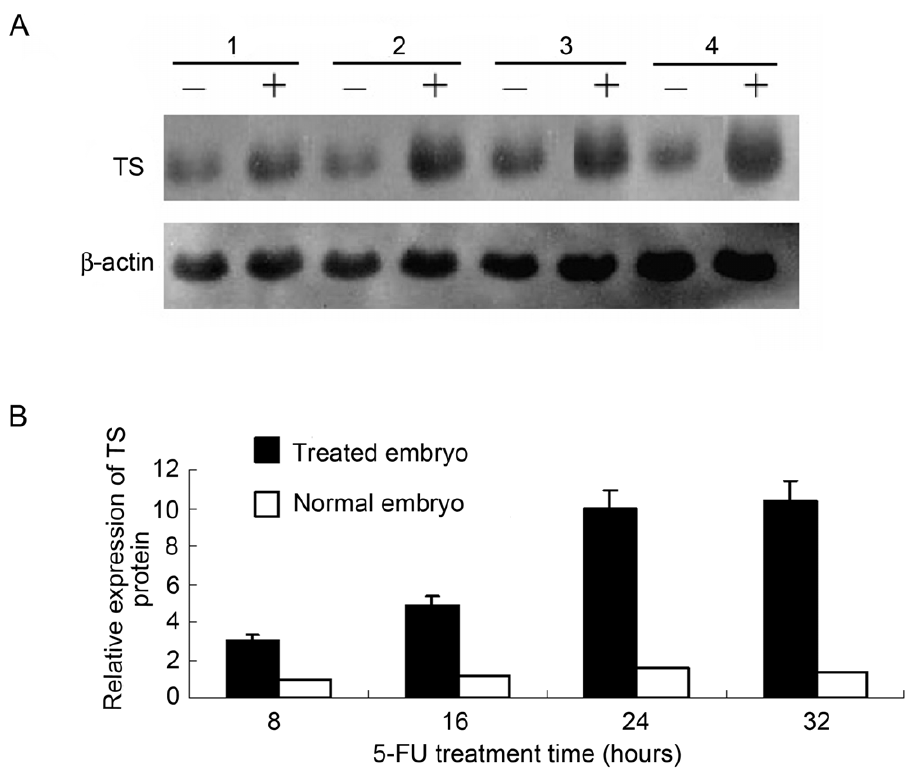
Figure 2. Time-dependent effect of 5-FU on TS expression. Zebrafish embryos (n=100) were untreated or treated with varying concentrations of 5-FU. A. Western immunoblot analyses were performed to evaluate TS levels in untreated zebrafish embryos or in embryos treated with 1.0 m M 5-FU for 8 h (lane 1), 16 h (lane 2), 24 h (lane 3) and 32 h (lane 4). b -actin was used as internal control. B. The quantification results of protein expression. The expression level of TS in untreated embryos at 8 h post-fertilization (hpf) was defined as 1.0. Each experiment was performed more than three times.